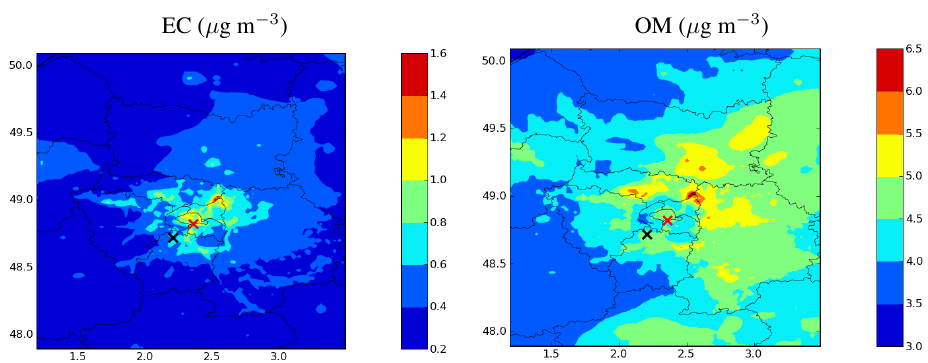
Fig. 3. Simulated concentrations in µgm − 3 of EC (left) and OM (right) for July 2009. The red and black crosses correspond to the LHVP and SIRTA sites, respectively.